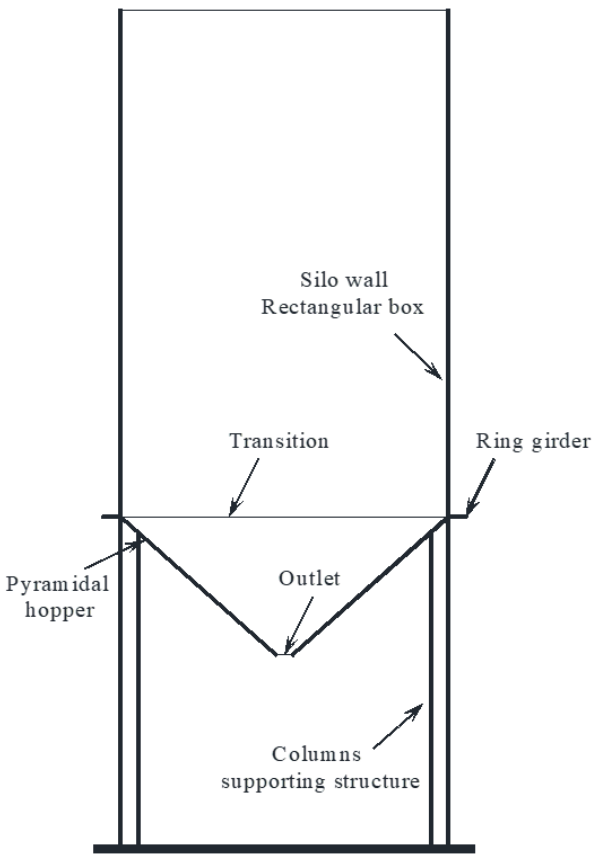
Figure 1. The main components of the rectangular planform silo.